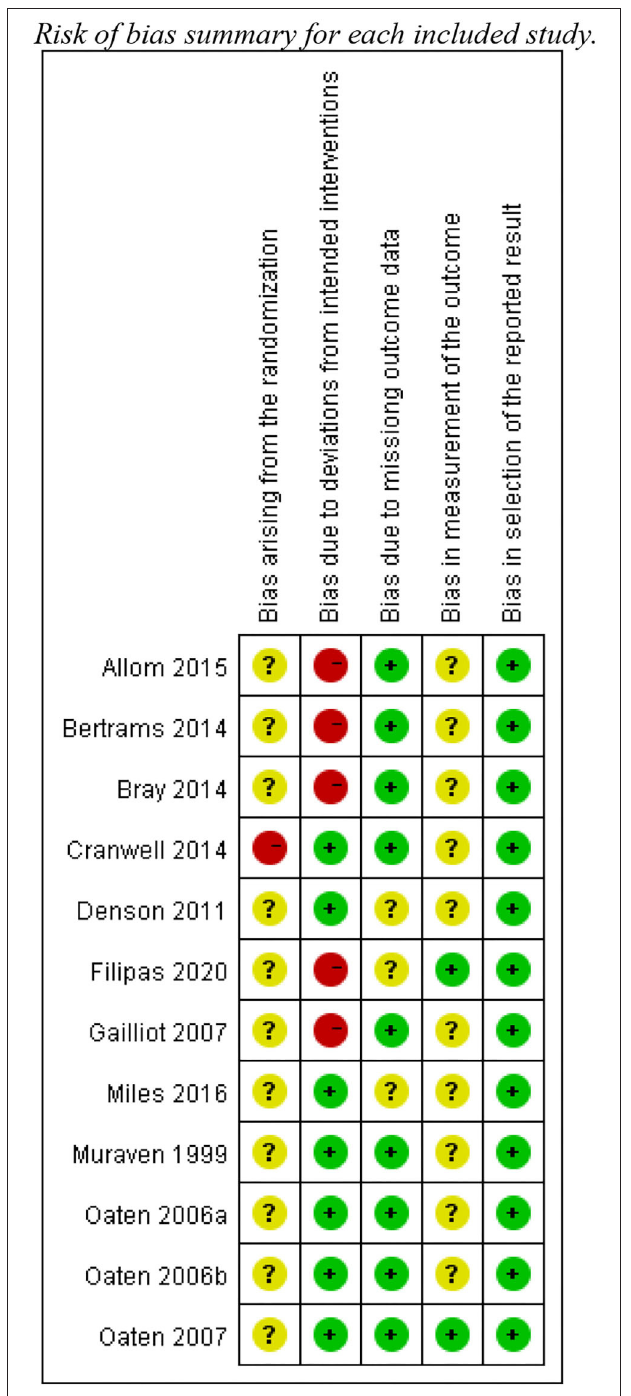
FIGURE 3 | Risk of bias summary for each included study.